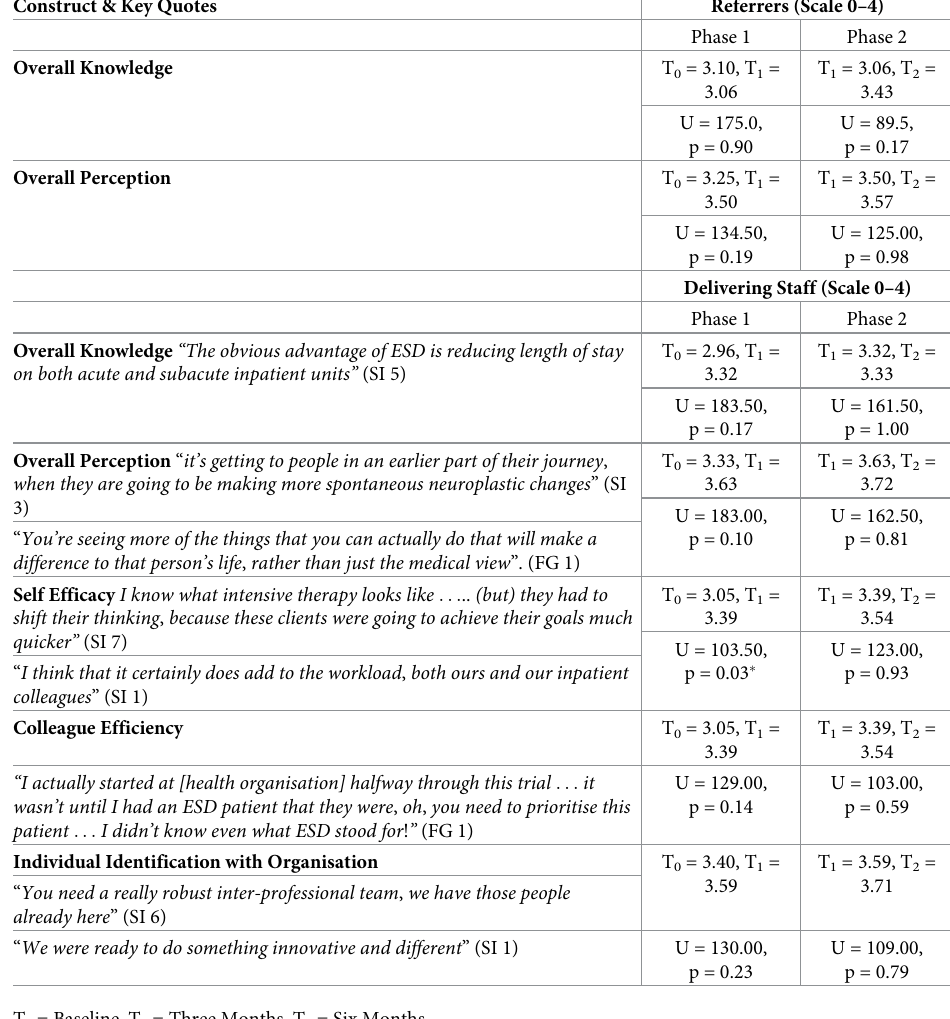
Table 2. Findings for characteristics of individuals